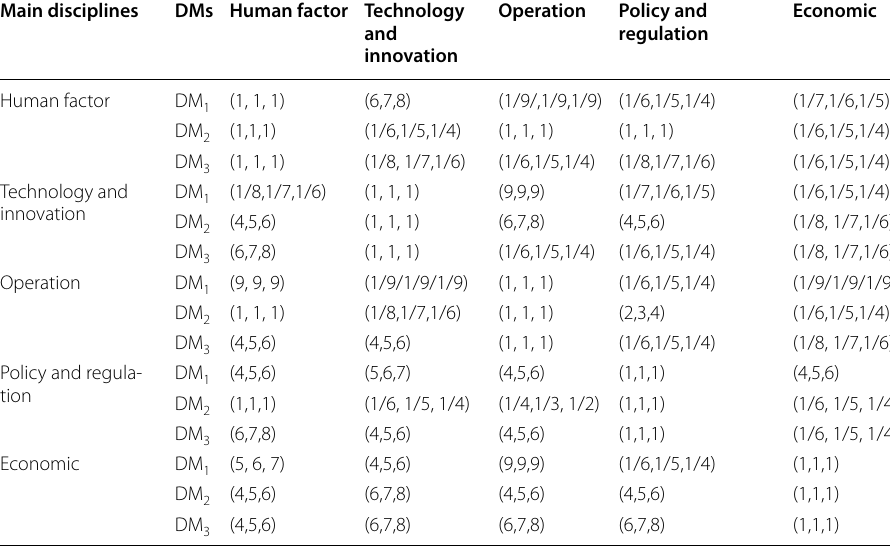
Table 9 Transformed preference of DMs (main disciplines) towards criteria into TFNs Main disciplines